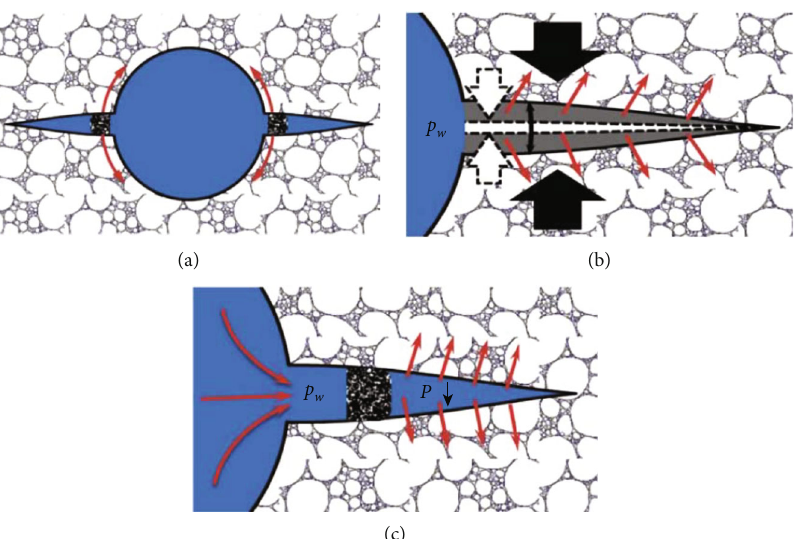
Figure 3: Common hypotheses related to mechanical wellbore strengthening. (a) Stress cage. (b) Fracture-closure stress. (c) Fracture- propagation resistance